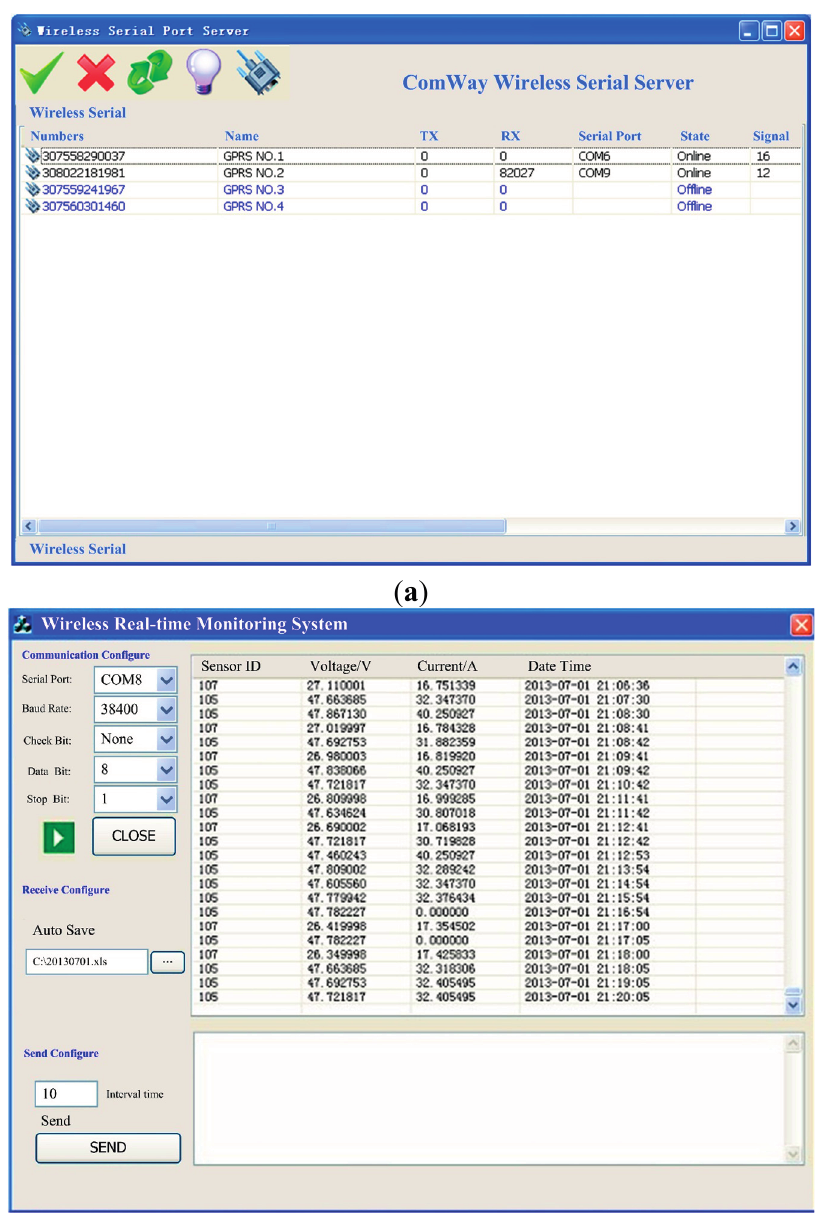
Figure 8. Communication configuration interface ( a ) and real-time data receiving interface in the remote monitoring center ( b